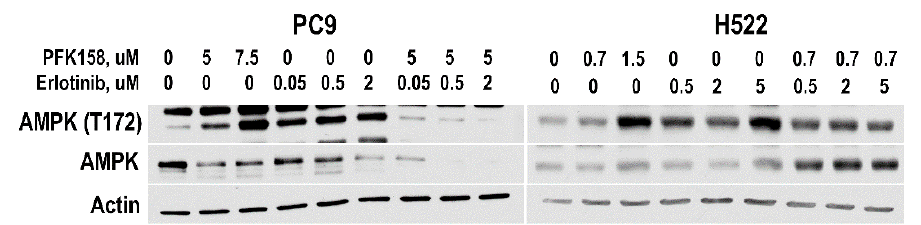
Figure 6. AMPK expression and phosphorylation in NSCLCs exposed to EGFR or PFKFB3 inhibitors. PC9 and H522 cells were exposed to different concentrations of erlotinib and PFK158 alone or in combination for 48 h. Levels of AMPK were evaluated by immunoblotting.